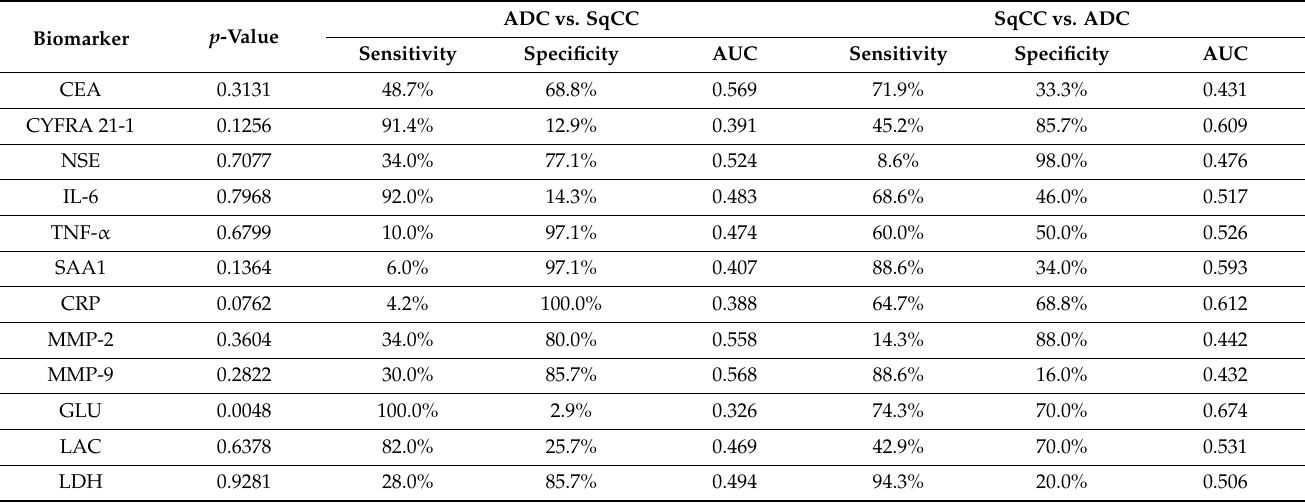
Table 7. The diagnostic efficiency of single biomarkers to distinguish NSCLC patients with adenocarcinoma and squamous cell carcinoma.